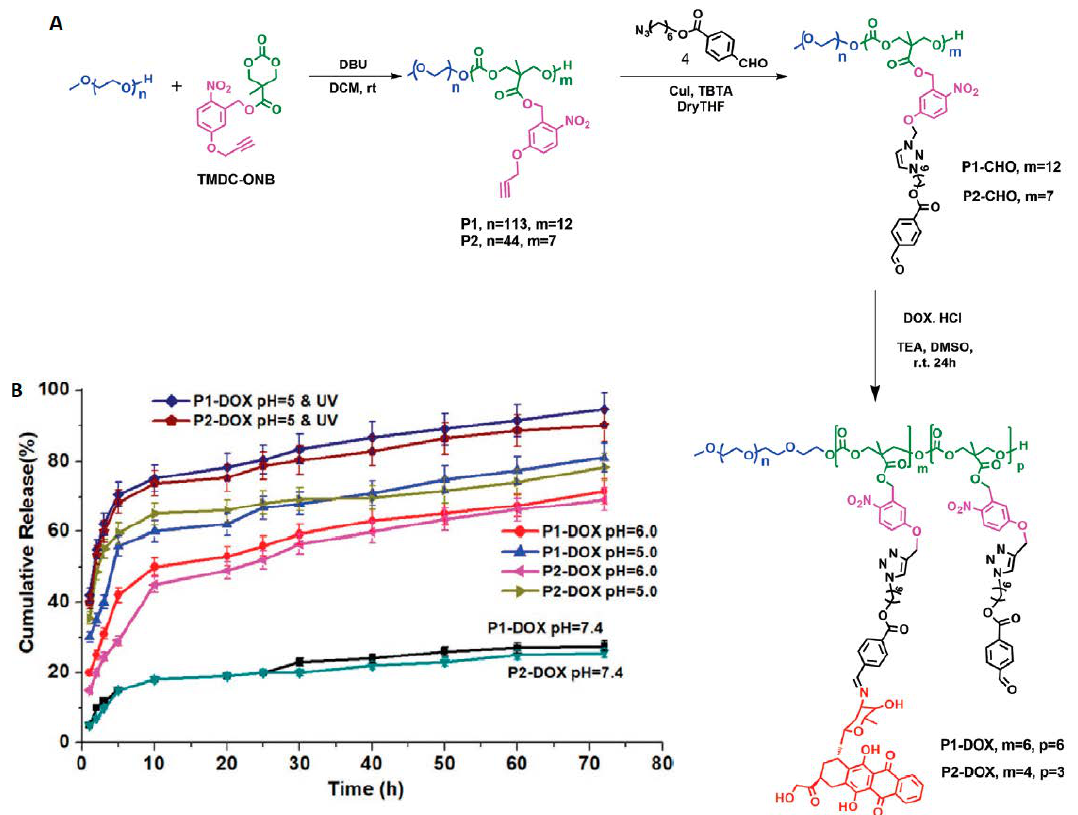
Figure 11. ( A ) Synthesis of photo- and pH-responsive poly(ethylene glycol)-poly(carbonate) block copolymer with nitrobenzyl ester and doxorubicin molecules conjugated via acid-sensitive Schiff-base linkage side groups. ( B ) In vitro cumulative release of DOX at pH 7.4, 6.0, 5.0, and pH 5.0 with 10 min UV light irradiation. Reprinted with permission from ref [164]. Copyright 2020 WILEY-VCH Verlag GmbH and Co. KGaA, Weinheim, Germany.